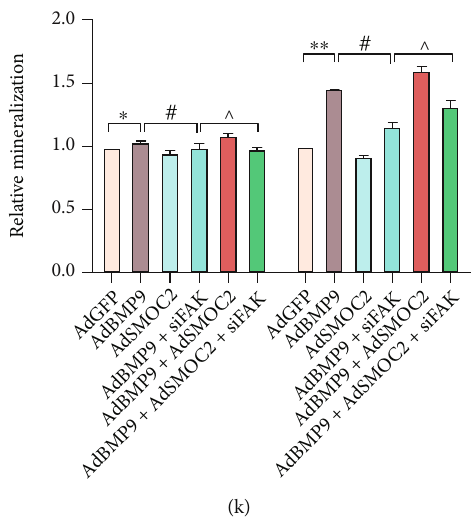
Figure 4: The activation of FAK signaling in the enhancement e ff ect of SMOC2 on BMP9-induced osteogenic di ff erentiation in MEFs. (a) Western blot assay results showed that the levels of p-FAK and FAK were a ff ected by BMP9 in MEFs at 30 h. (b) Quanti fi cation of the Western blot results showed that the levels of p-FAK and FAK were a ff ected by BMP9. (c) ALP assay results showed the e ff ect of FAK knockdown on the activity of ALP induced by BMP9 in MEFs. (d) Quanti fi cation results of the ALP assay showed the e ff ect of FAK knockdown on the activity of ALP induced by BMP9. (e) Western blot assay results showed the e ff ect of SMOC2 on the expression of p-FAK and p-AKT promoted by BMP9 in MEFs. (f – g) The quanti fi cation results of western blotting showed the e ff ect of SMOC2 on the expression of p-FAK and p-AKT promoted by BMP9 in MEFs. (h) ALP assay results showed the reverse e ff ect of SMOC2 on the e ff ect of FAK knockdown on the BMP9-induced activity of ALP. (i) Quanti fi cation results of the ALP assay showed the reversal e ff ect of SMOC2 on the e ff ect of FAK knockdown on the BMP9-induced activity of ALP in MEFs. (j) Alizarin Red S staining showed the reversal e ff ect of SMOC2 on the e ff ect of FAK knockdown on BMP9-induced mineralization in MEFs. (k) Quanti fi cation results of Alizarin Red S staining showed the e ff ect of SMOC2 on the e ff ect of FAK knockdown on BMP9-induced mineralization in MEFs. Compared with the control group, ∗ p < 0 : 05 ; ∗∗ p < 0 : 01 ; compared with the AdBMP9 group, # p < 0 : 05 , ## p < 0 : 01 ; compared with the AdBMP9 and siFAK group, ^ p < 0 : 05 , ^^ p < 0 : 01 e ff ect of SMOC2 on BMP9-induced osteogenesis could be